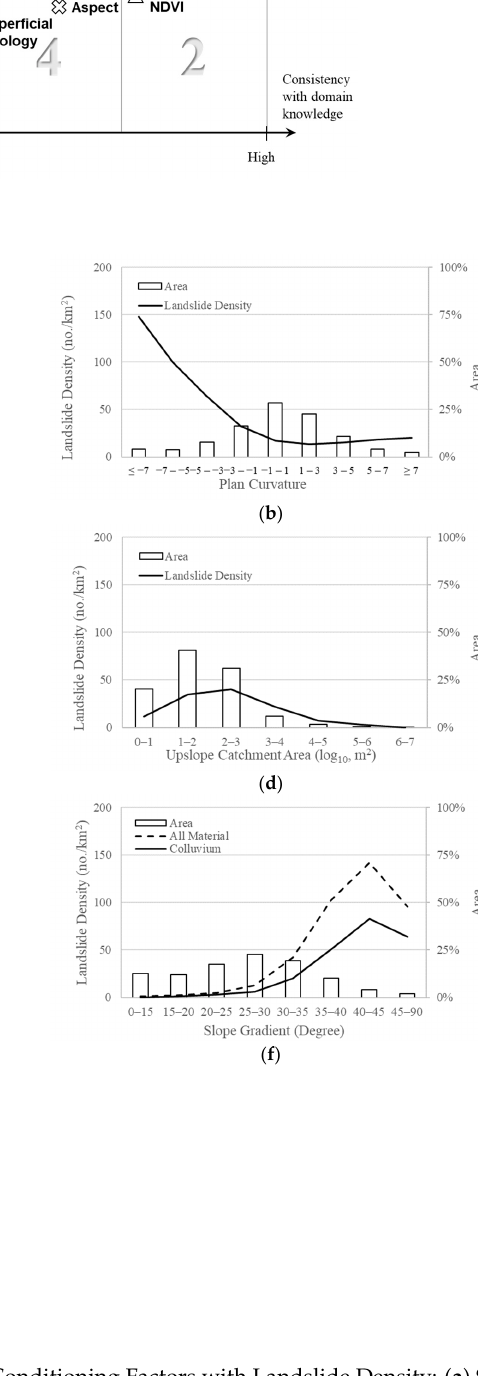
Figure 6. Statistical Correlation of Landslide Conditioning Factors with Landslide Density: ( a ) Slope gradient; ( b ) Plan curvature; ( c ) Profile curvature; ( d ) Upslope catchment area; ( e ) Normalized Difference Vegetation Index (NDVI); ( f ) Superficial geology (the effect of slope angle to the landslide occurrence is normalized); ( g )